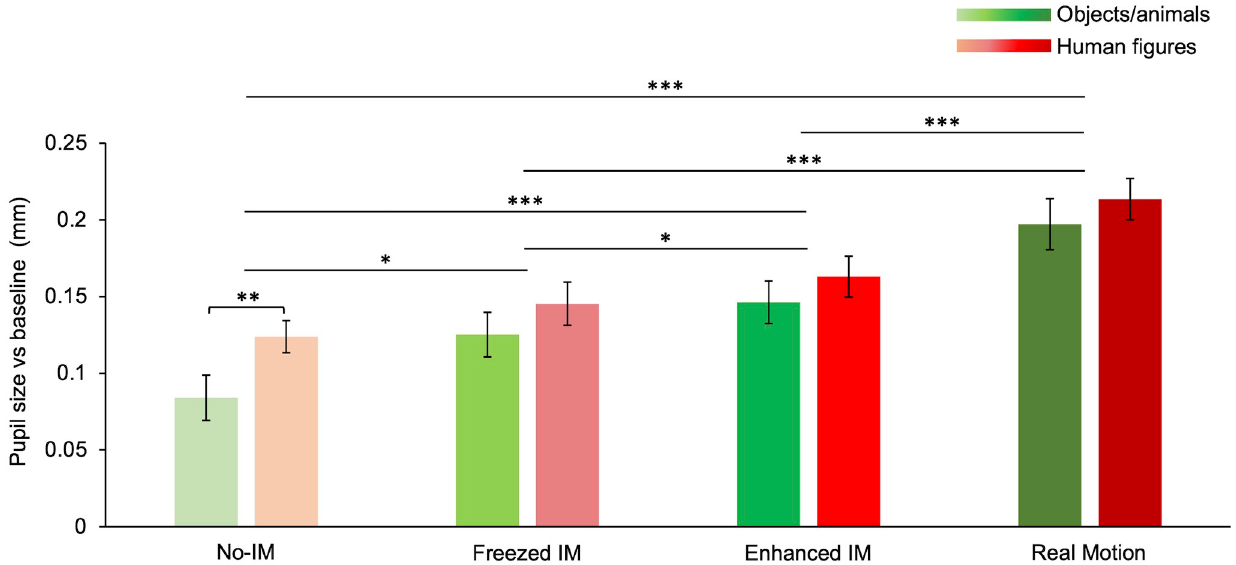
Fig 5. Pupillary response to different motion categories and stimulus content. Comparison between the mean pupillary dilation for different motion categories and subjects (objects/animals’: green; humans: red). Color saturation of bars increases with motion strength, in order: No-IM, Freezed IM, Enhanced IM, Real Motion (see S1 List for stimuli). Error bars are SE. Asterisks mark statistically significant post-hoc comparisons: � p < 0.05, �� p < 0.01, ��� p < 0.001. All data shown were corrected based on each observer’s motion rating